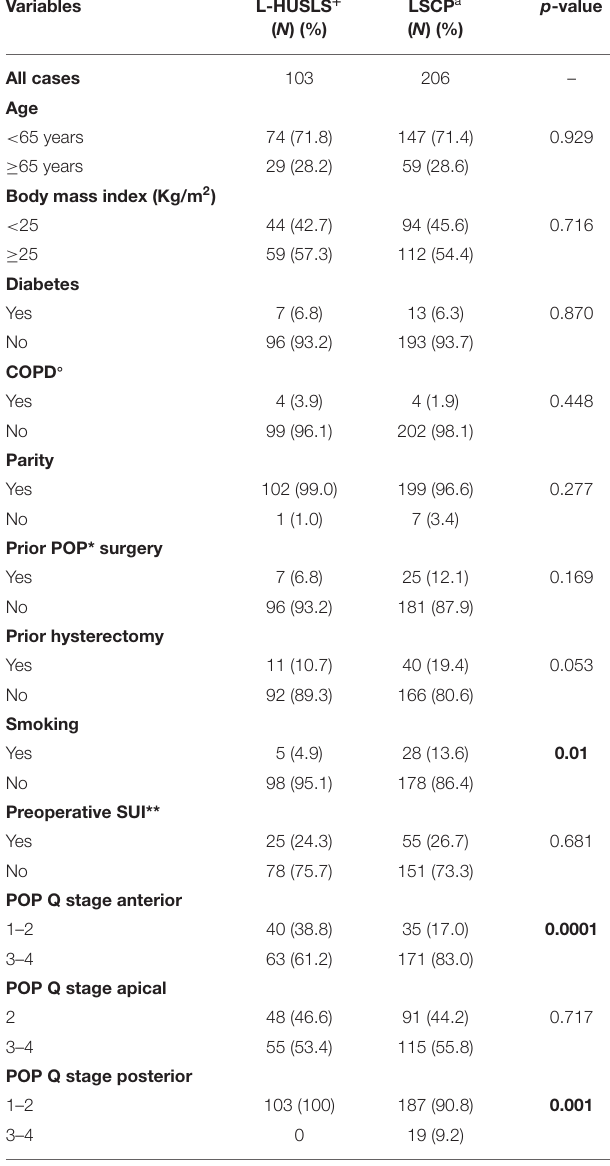
TABLE 1 | Baseline patients